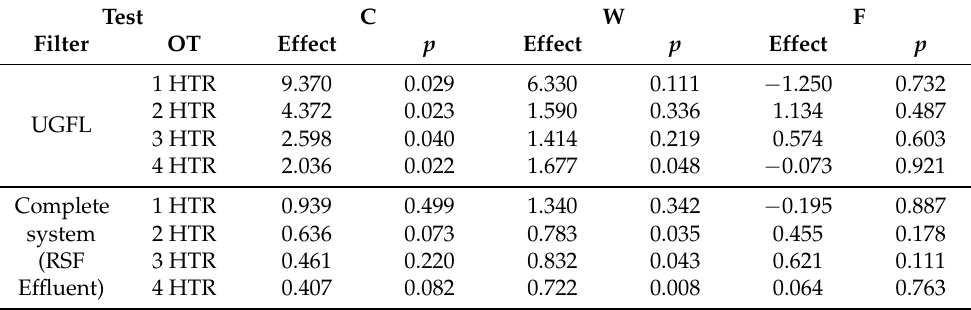
Table 7. Standardised effects of the factors.